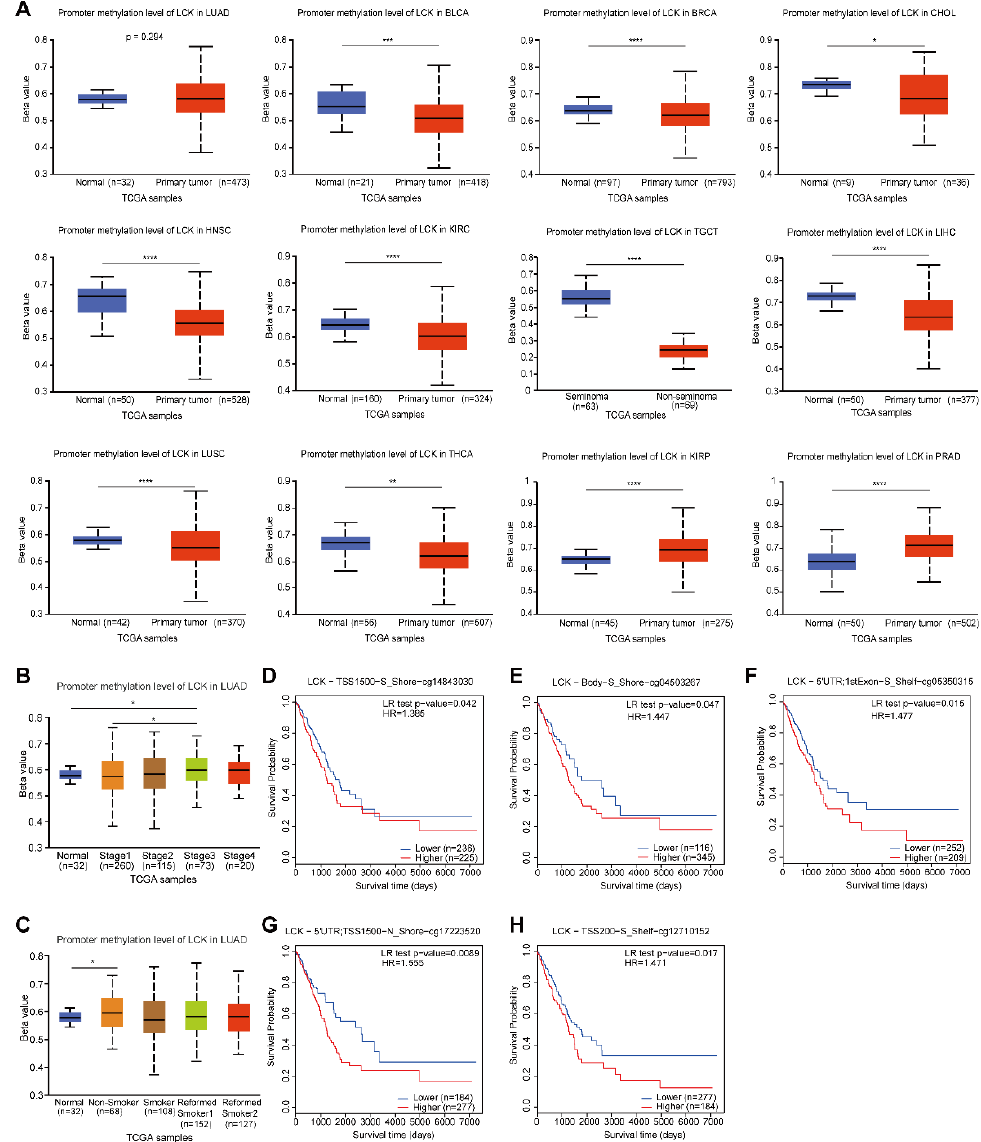
Figure 4. LCK DNA methylation in different tumors and its influence on the survival of patients with LUAD. (* p < 0.05, ** p < 0.01, *** p < 0.001, **** p < 0.0001). ( A ) The promoter methylation level of LCK in normal tissues and tumors across multiple tumor types. ( B , C ) The promoter methylation level of LCK in LUAD based on ( B ) sample stages and ( C ) smoking history. ( D – H ) The correlation between five CpGs methylation levels, ( D ) TSS1500-S_Shore-cg14843030, ( E ) Body-S_Shore-cg041503267, ( F ) 5 ′ UTR; 1stExon-S_Shelf-cg05350315, ( G ) 5 ′ UTR; TSS1500-N_Shore-cg17223520, and ( H ) TSS200-S_Shelf-cg12710152, and their effects on the overall survival evaluating by the Kaplan– Meier test module in MethSurv.